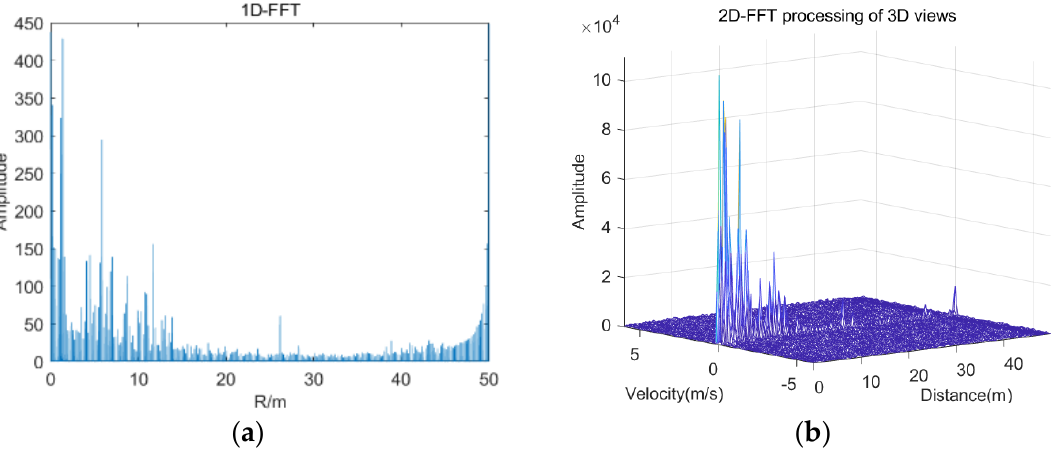
Figure 4. ( a ) Distance Doppler spectrogram (bending down to pick something up). ( b ) Distance − velocity Doppler spectrum (bending down to pick something up).